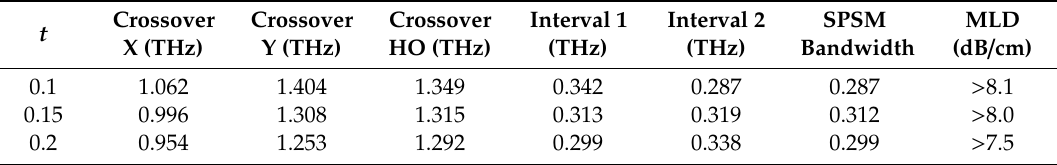
Table 2. Crossover points, interval size, SPSM bandwidth, and MLD values for di ff erent ENZ ring thicknesses ( t ).